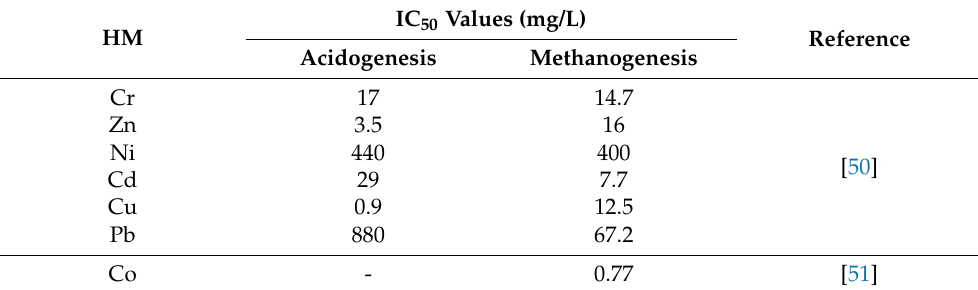
Table 2. IC 50 value of major heavy metals (HMs) in the anaerobic digestion (AD)